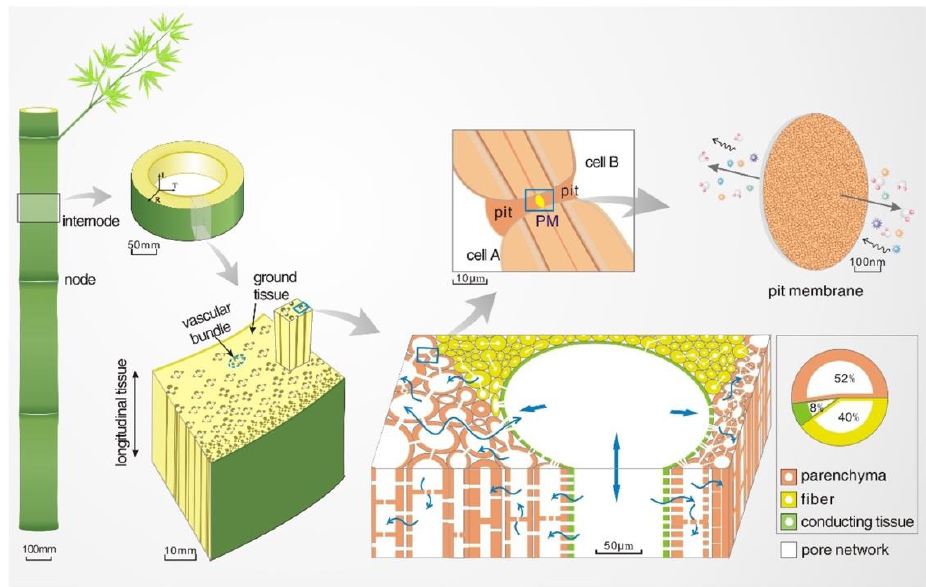
Figure 7. Hierarchical pore network in bamboo moso. Reprinted with permission from [32], copyright 2021, Elsevier.